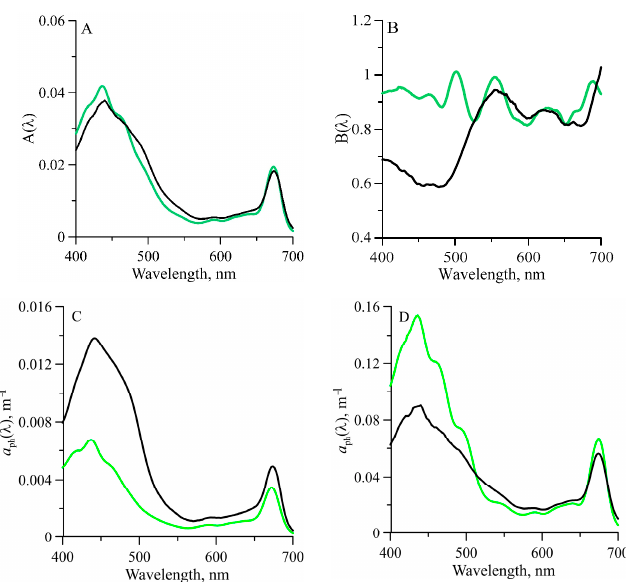
Figure 6. Values of the spectral constant A ( λ ) ( A ) and B ( λ ) ( B ) obtained when fitting power laws in the form of Equation (7) of the variations of phytoplankton light absorption coefficients ( a ph ( λ ) ) versus the sum of chlorophyll a and phaeopigment concentrations (TChl- a ) for the euphotic zone of the Atlantic sector of the Southern Ocean from 11 January–4 February 2020 (green lines). Comparison data are shown for a global ocean data set (black lines) described by [50]. The a ph ( λ ) spectra modeled using our parameterization coefficients when TChl- a equal 0.2 mg m − 3 ( C ) and 4.0 mg m − 3 ( D ) (green line) and [50] (black line) are shown for